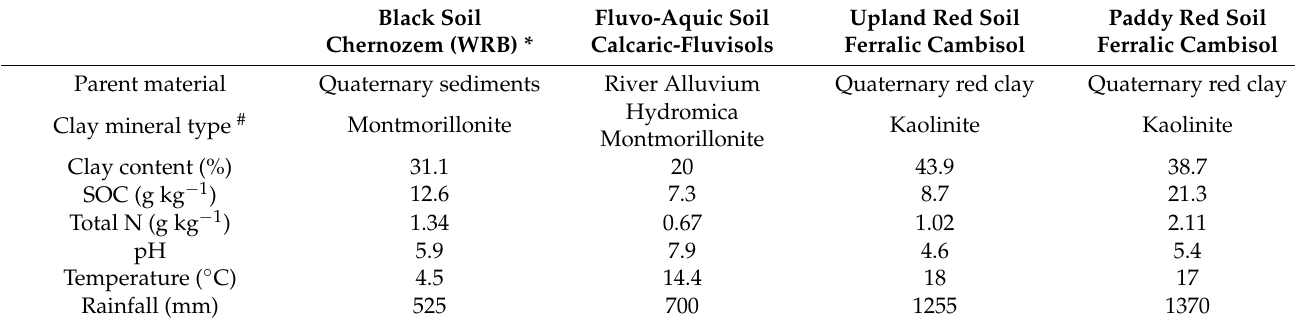
Table 1. Soil properties and meteorological data of the four study